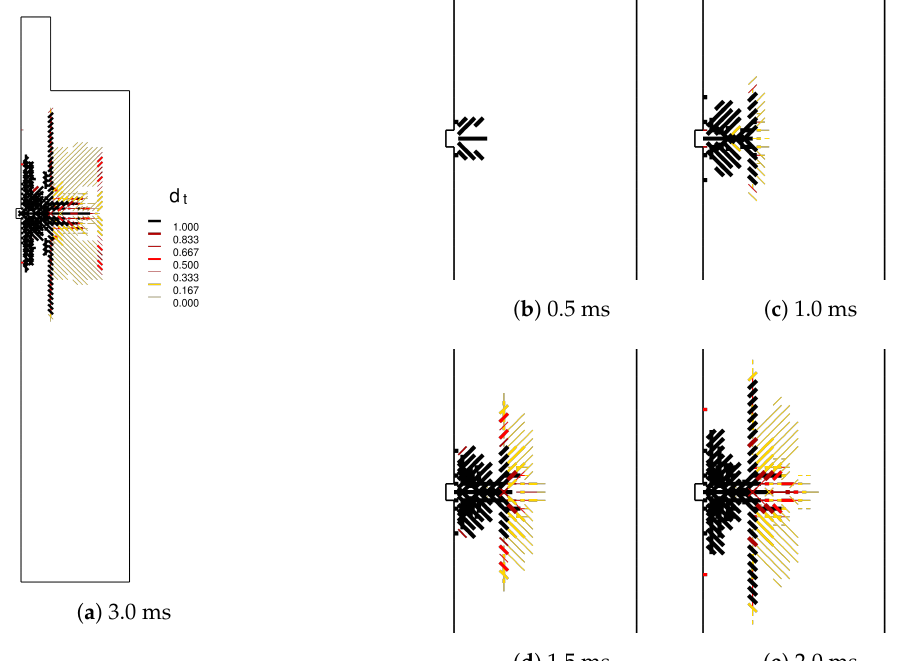
Figure 14. Maps of the tensile spring damage ( d t ) and zoom on the impact point at different points in